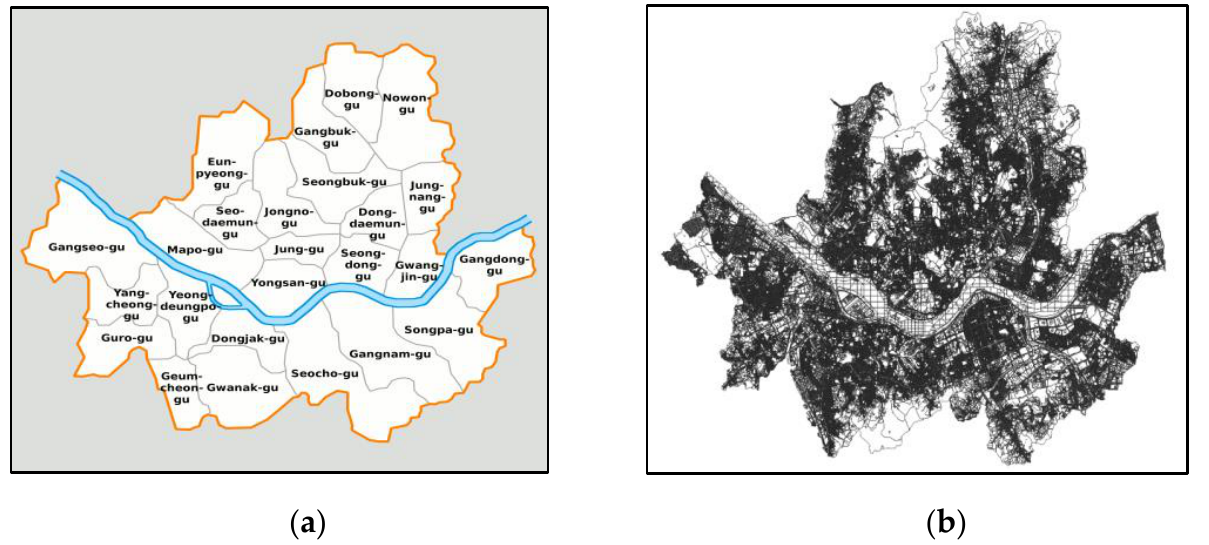
Figure 3. Map of Seoul, Korea: ( a ) Administrative districts [33]; ( b ) vector image on a GIS application .